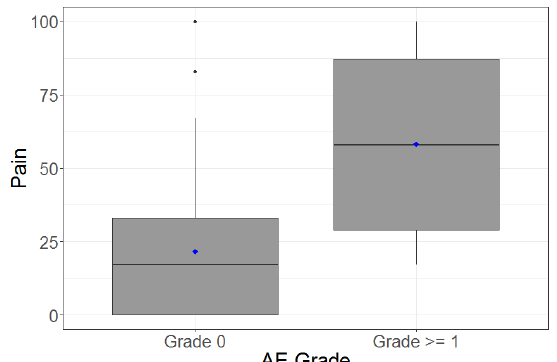
Figure 3. Box and whisker plots showing the patient-reported outcomes on the y-axis plotted against clinician-reported adverse events on the x-axis, grouped into grade 0 or grade ≥ 1. The boxes represent means (bold lines), upper and lower quartile scores while whiskers represent the maximum and minimum scores.